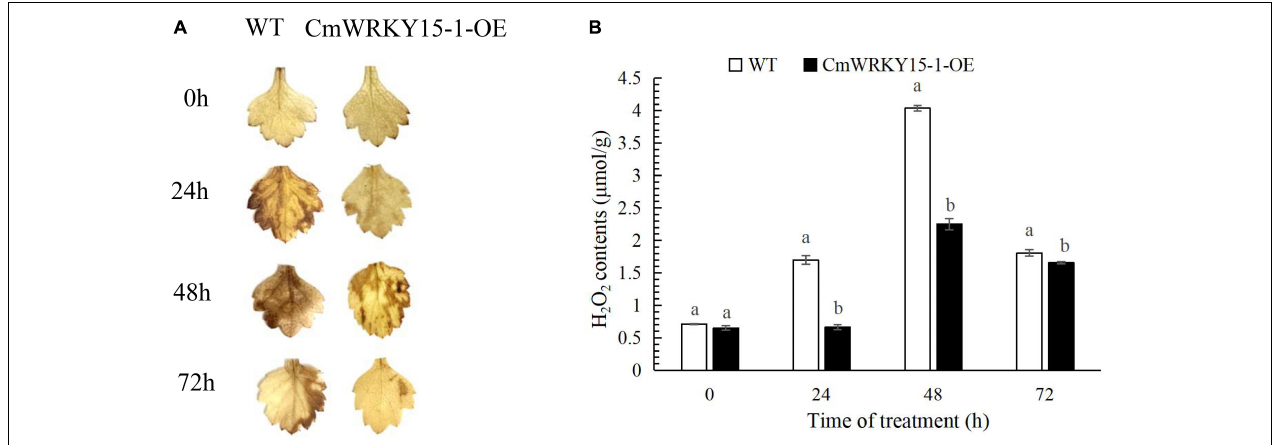
FIGURE 1 | Changes in the levels of H 2 O 2 in wild-type (WT) and CmWRKY15-1- overexpressing (OE) lines of ‘Jinba.’ (A) DAB staining of detached leaves to observe H